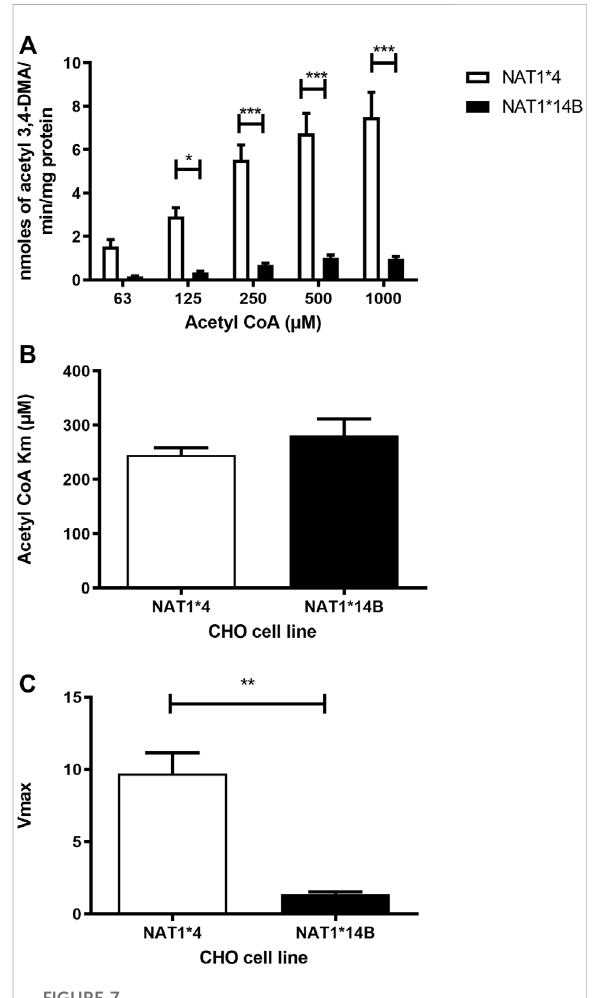
catalytic activities towards 3,4-DMA using AcCoA (62.5 – 1,000 µM). (B) Apparent AcCoA K m did not signi fi cantly differ between both alleles. (C) V max (nmol/min/mg) was signi fi cantly higher in NAT1*4 compared to NAT1*14B. Data representsMean±S.E.M.ofthreeseparateexperiments(* p < 0.05, ** p < 0.01, *** p < 0.001).